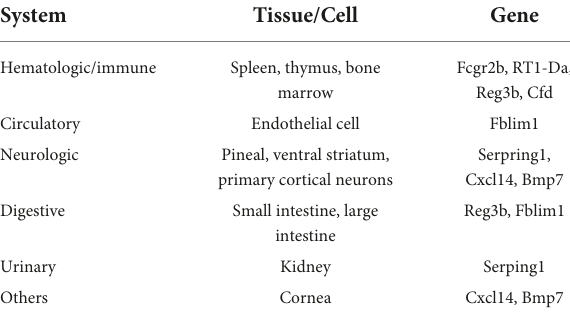
The results of GSEA analyses consistently